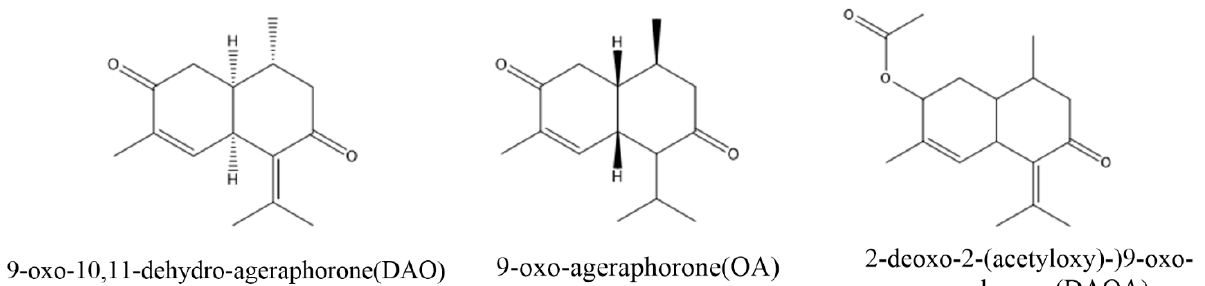
Figure 1. Structure of major toxins compounds in A.